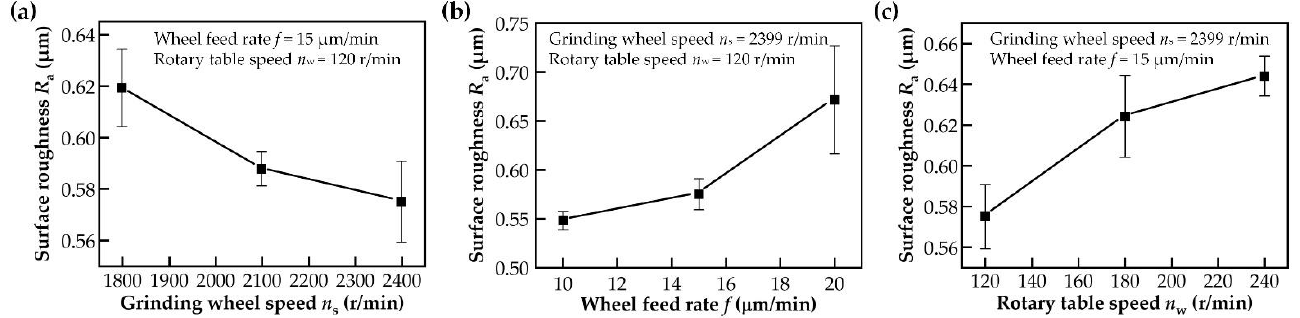
Figure 3. Effect of different grinding parameters on the surface roughness of PEEK: ( a ) effect of grinding wheel speed; ( b ) effect of wheel feed rate; ( c ) effect of rotary table speed.